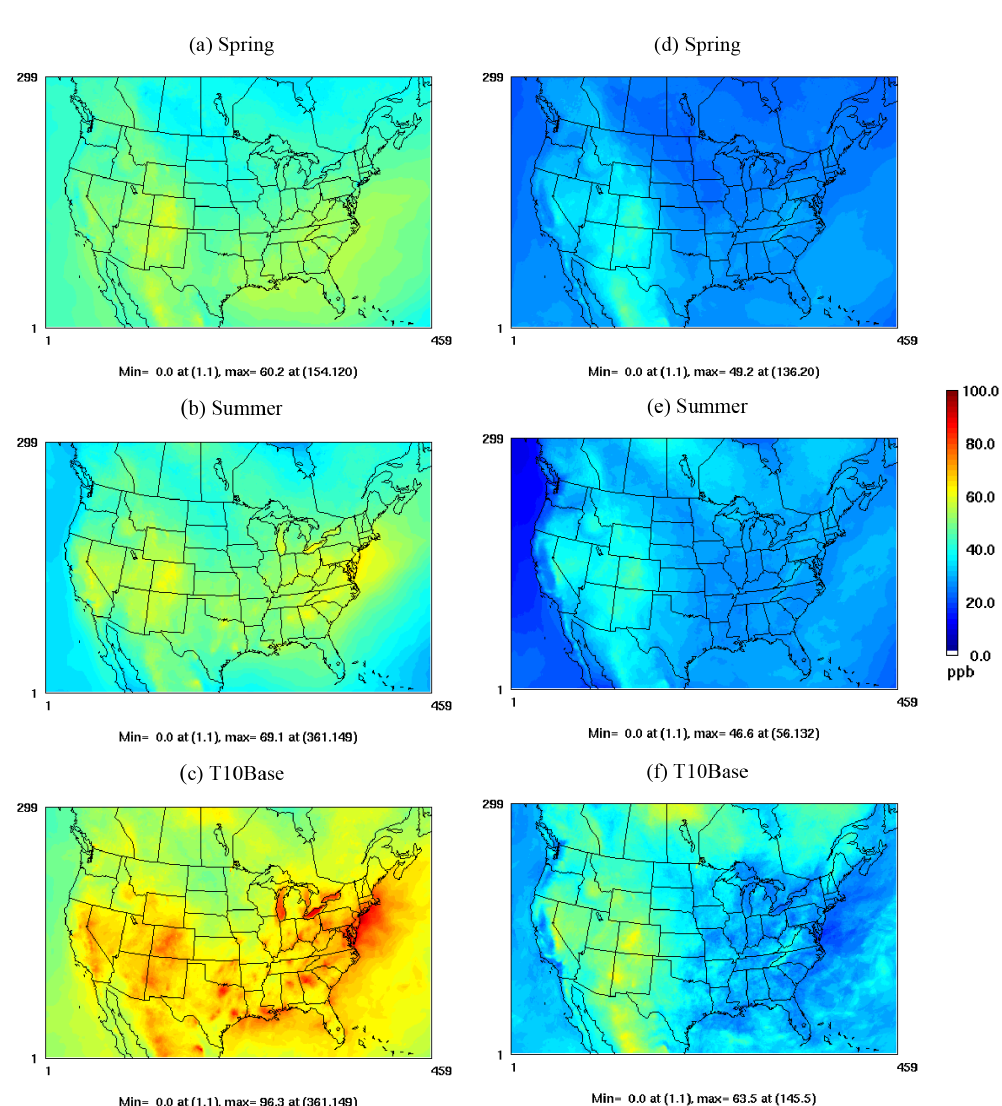
Figure 7. MDA8 O 3 concentrations from the CAMx base ( a – c ) and background ( d – f ) simulations averaged over spring (March–May), summer (June–August), and the 10 days in the base case with the largest concentrations during March–September 2010